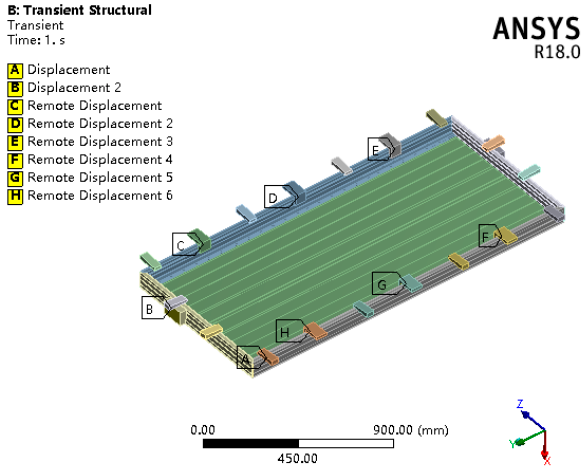
Figure 6. Constraints of the power battery enclosure.